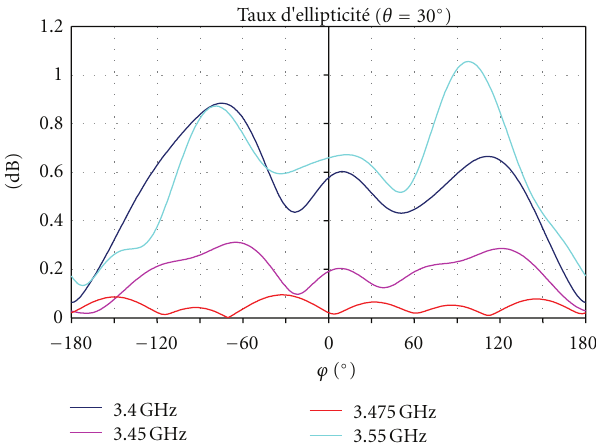
Figure 11: Axial ratio obtained with the linear combination of (1). Notice the agreement with the objectives at